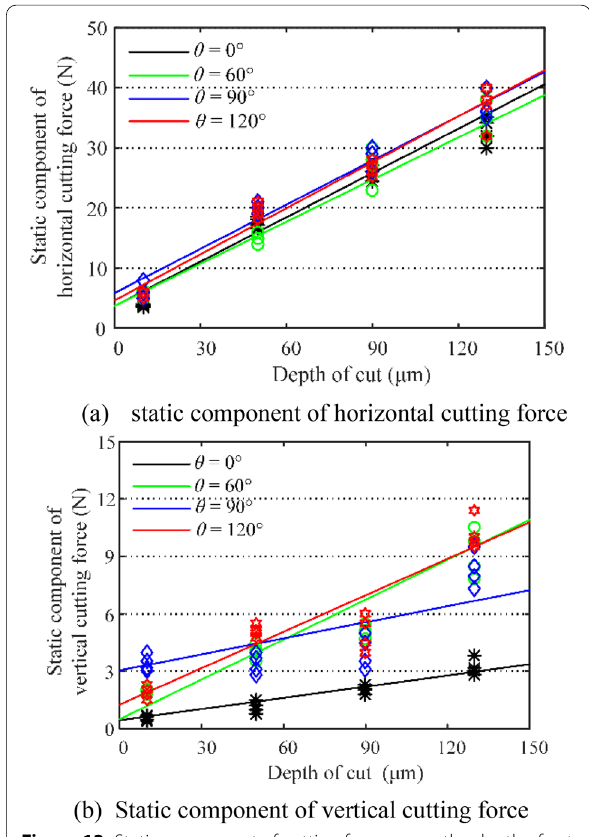
Figure 13 Static component of cutting force versus the depth of cut